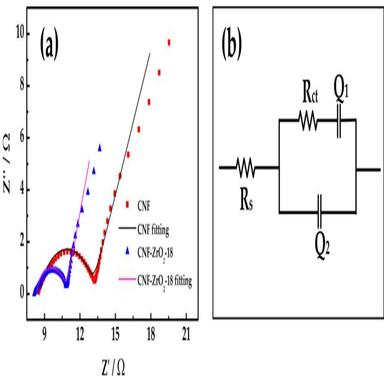
Nyquist plots for CNF and CNFeZrO2-18 towards V2þ/V3þ redox reaction at the polarization potential of 0.45 V in 1.6 mol L1 V3þ þ 3.0 mol L1 H2SO4 electrolyte (a), and corresponding equivalent circuit representing the circuit elements in Nyquist spectra (b).